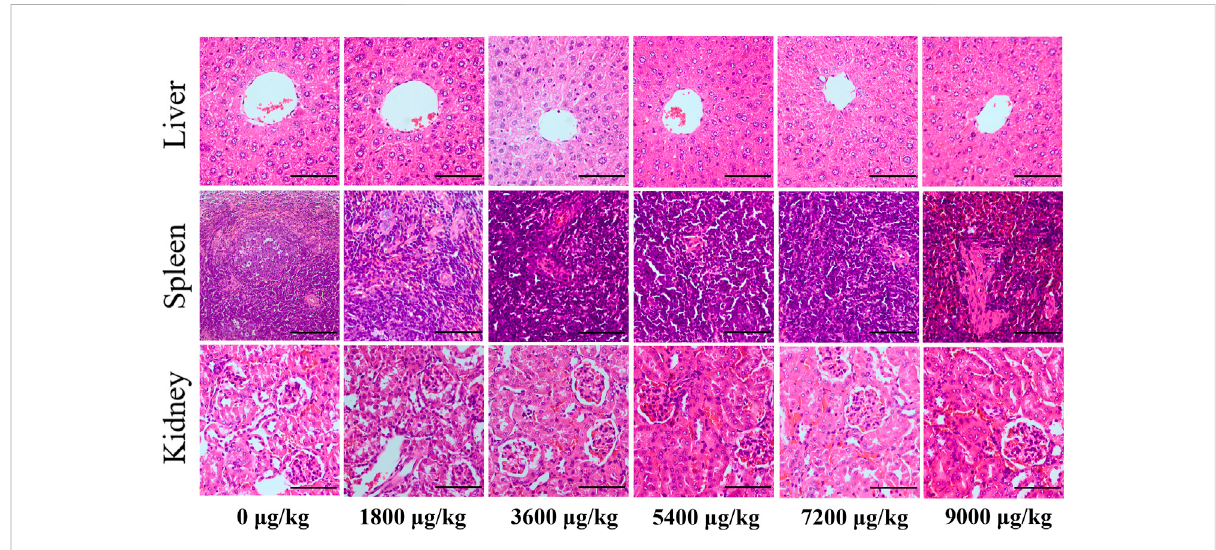
FIGURE 4 Pathological sections of the liver, spleen, and kidney from mice in the in vivo toxicity evaluation of CuS-BSA NPs (×400). Scale bars represent 100 μ